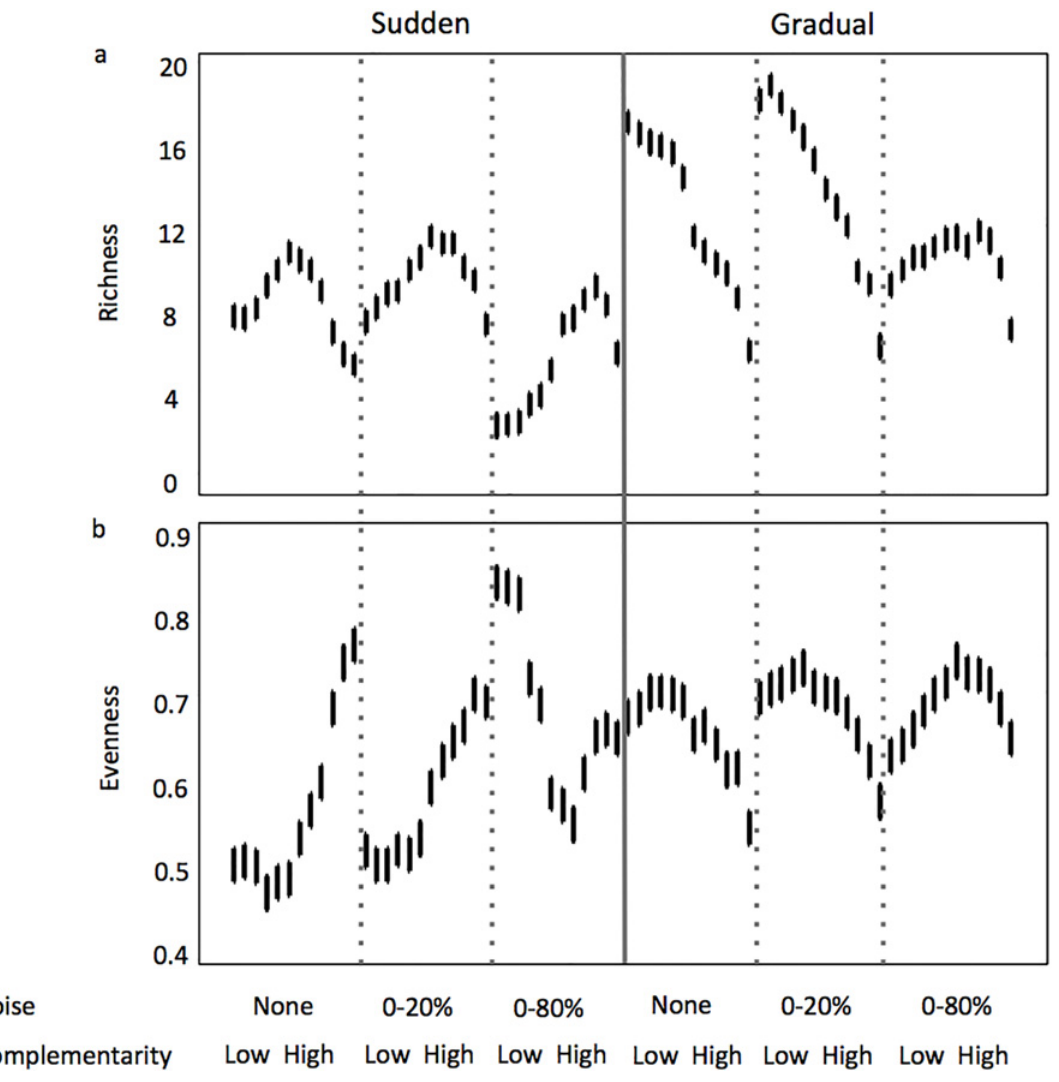
Fig 4. Variability of species richness (number of coexisting species) (a) and evenness (index based on biomasses of co-occurring populations) (b) along a gradient of increasing complementarity in the assemblages and noise in resource concentration from the supply, when the reversal in resource supply concentrations is sudden and gradual. Error bars represent 95% confidence